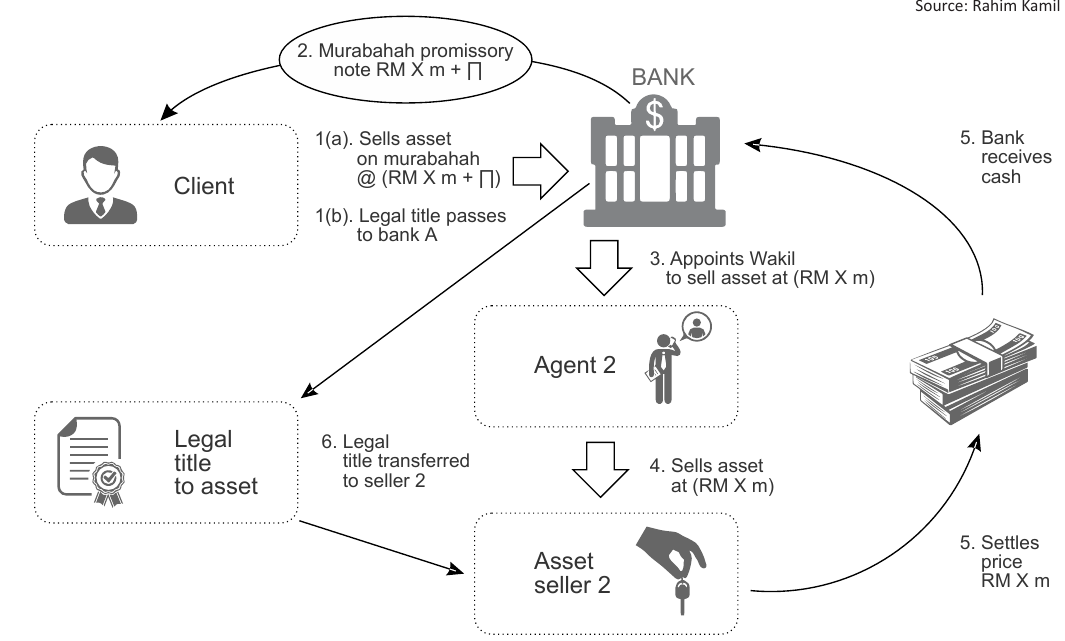
Figure 2. The second stage of mainstream